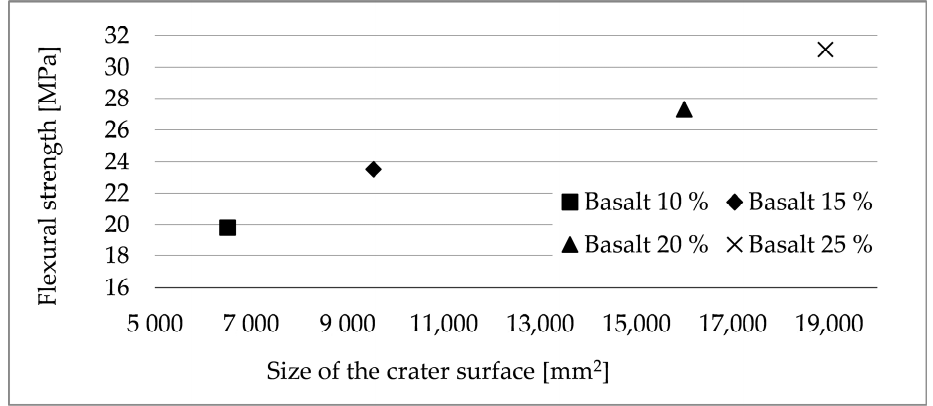
Figure 20. Dependence of the rear crater area on the flexural strength according to individual percentage